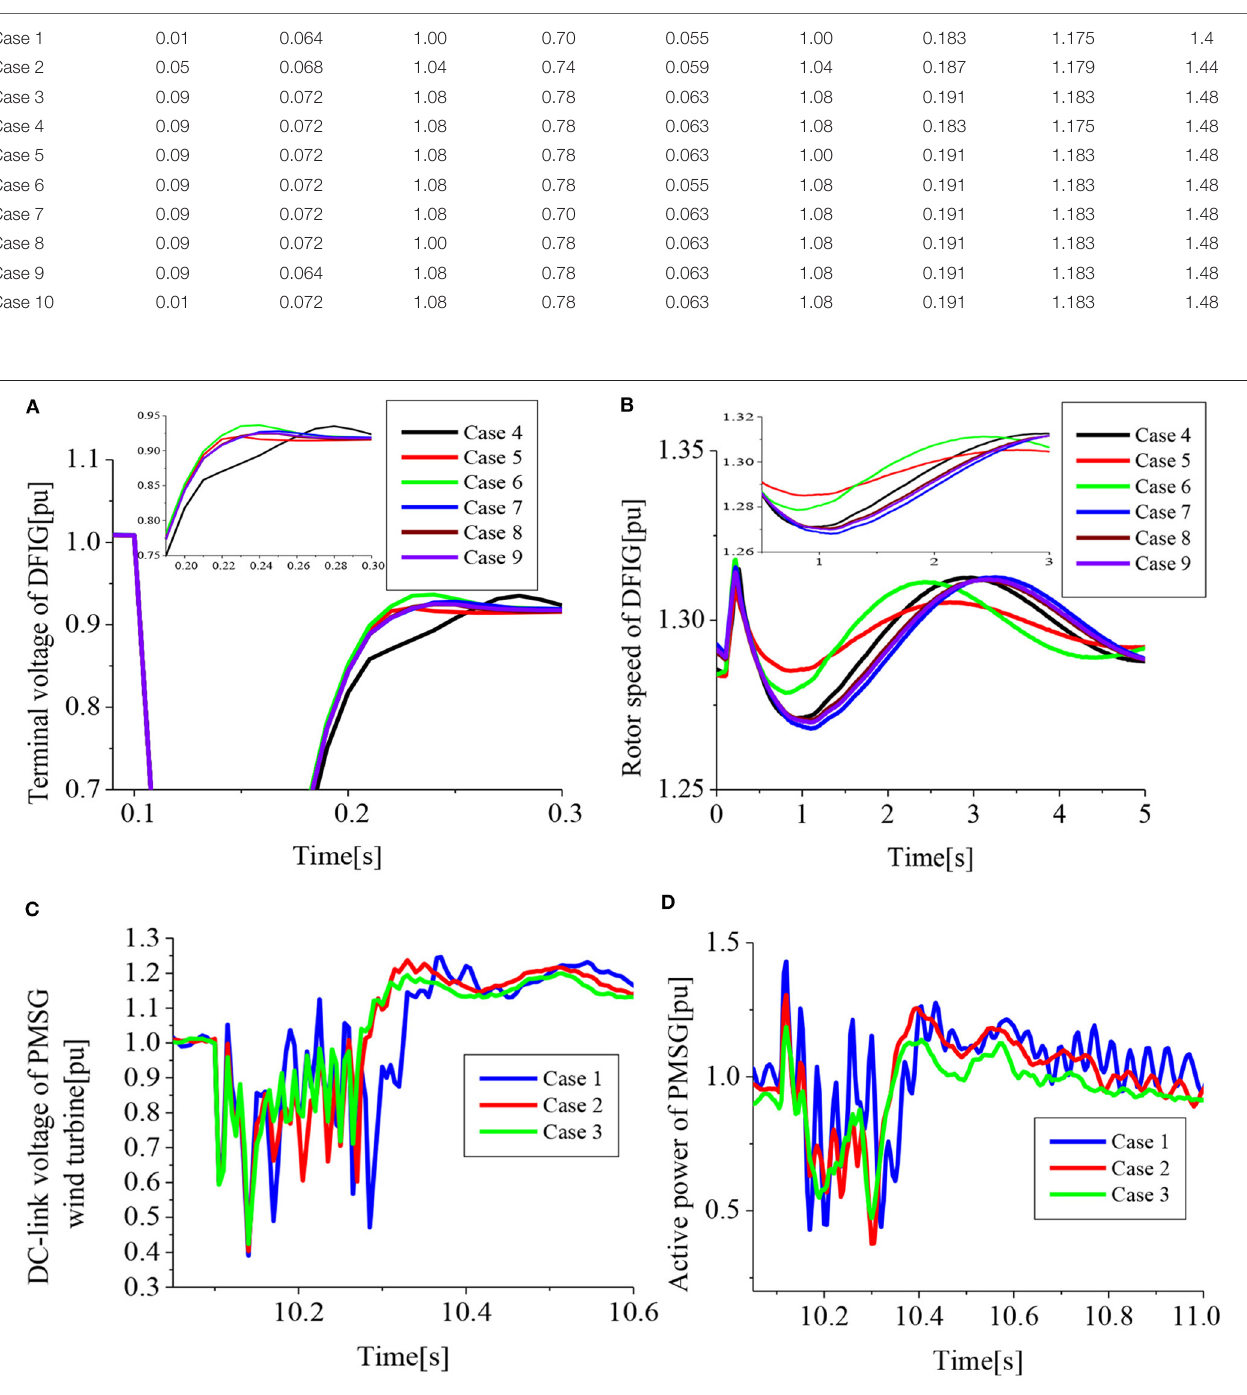
Frontiers in Energy Research |